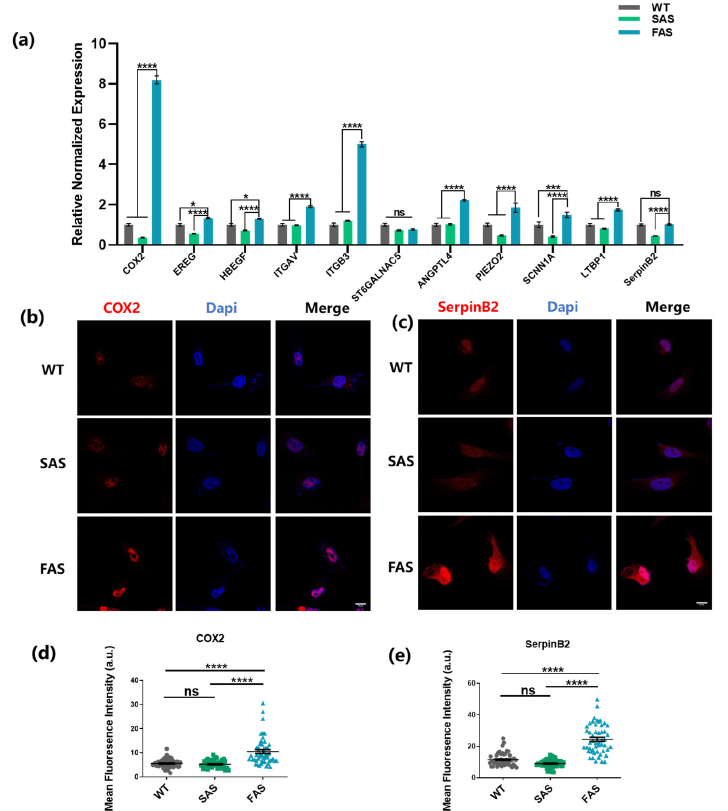
Figure 2. FAS cells up-regulate brain metastasis genes. ( a ) FAS cells showed enhanced expressions of brain metastasis-related genes. The gene expression was evaluated using qPCR. The statistics were calculated using two-way ANOVA with the post hoc Tukey test. n = 3. ( b , c ) The expressions of COX2 and SerpinB2 in all groups were tested using immuno fl uorescence staining. Scale bar = 10 µm. ( d , e ) Quanti fi cation of the fl uorescence intensity of COX2 and SerpinB2 in ( b , c ). The statistics among three groups were calculated based on one-way ANOVA with the post hoc Bonferroni test. n = 50. (ns: no signi fi cance, * p < 0.05, *** p < 0.001, **** p < 0.0001).